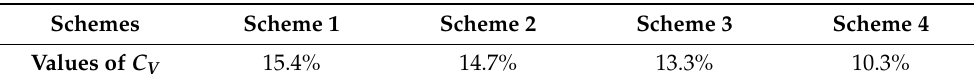
Table 2. Summary of C V values of the velocity field distribution upstream of the AIG corresponding to different schemes.